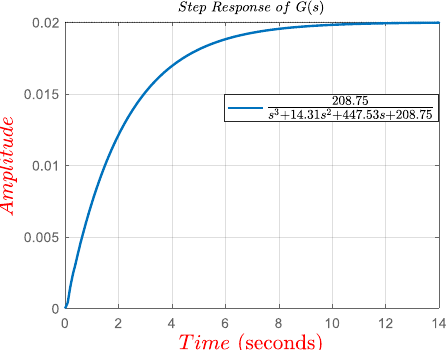
Figure 4. Step response of 𝐺(𝑠) with a 0.02 M input.